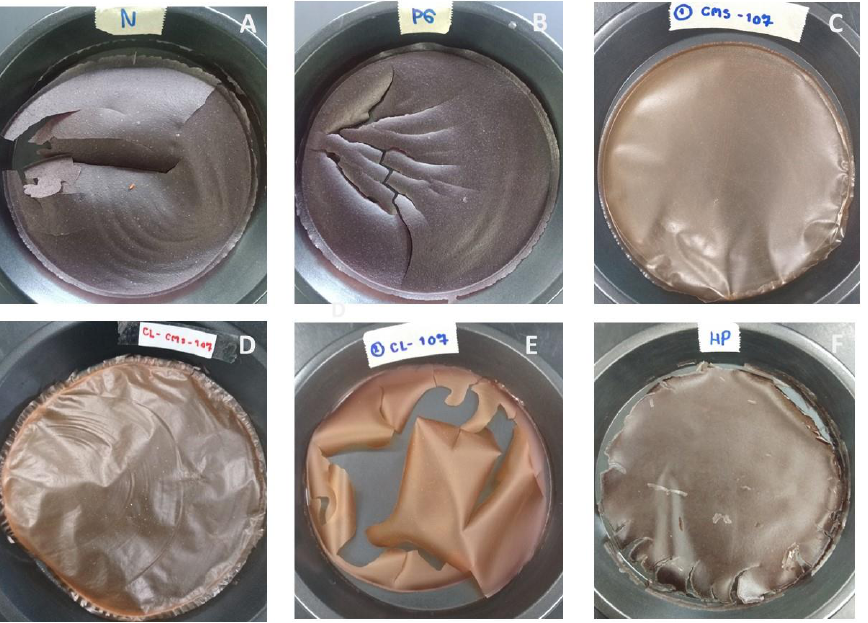
Figure 8. Films Prepared from ( A ) NS, ( B ) PGS, ( C ) CMS, ( D ) CLCMS, ( E ) CLS, and ( F ) HPS. Casting Solution Contained 5% w/v Starch; Drying Was at 50 °C for 16 h. Solution Contained 5% w / v Starch; Drying Was at 50 ◦ C for 16